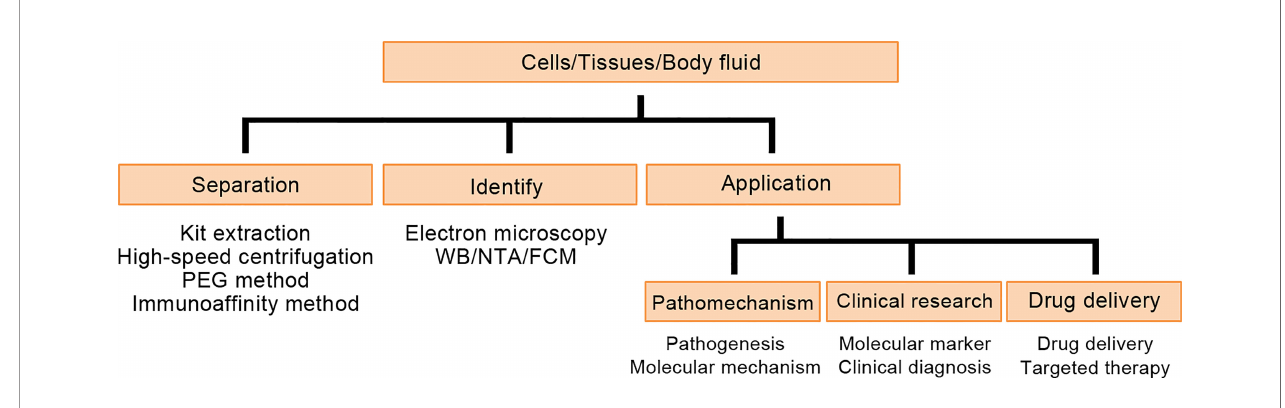
FIGURE 4 | Detection process and application